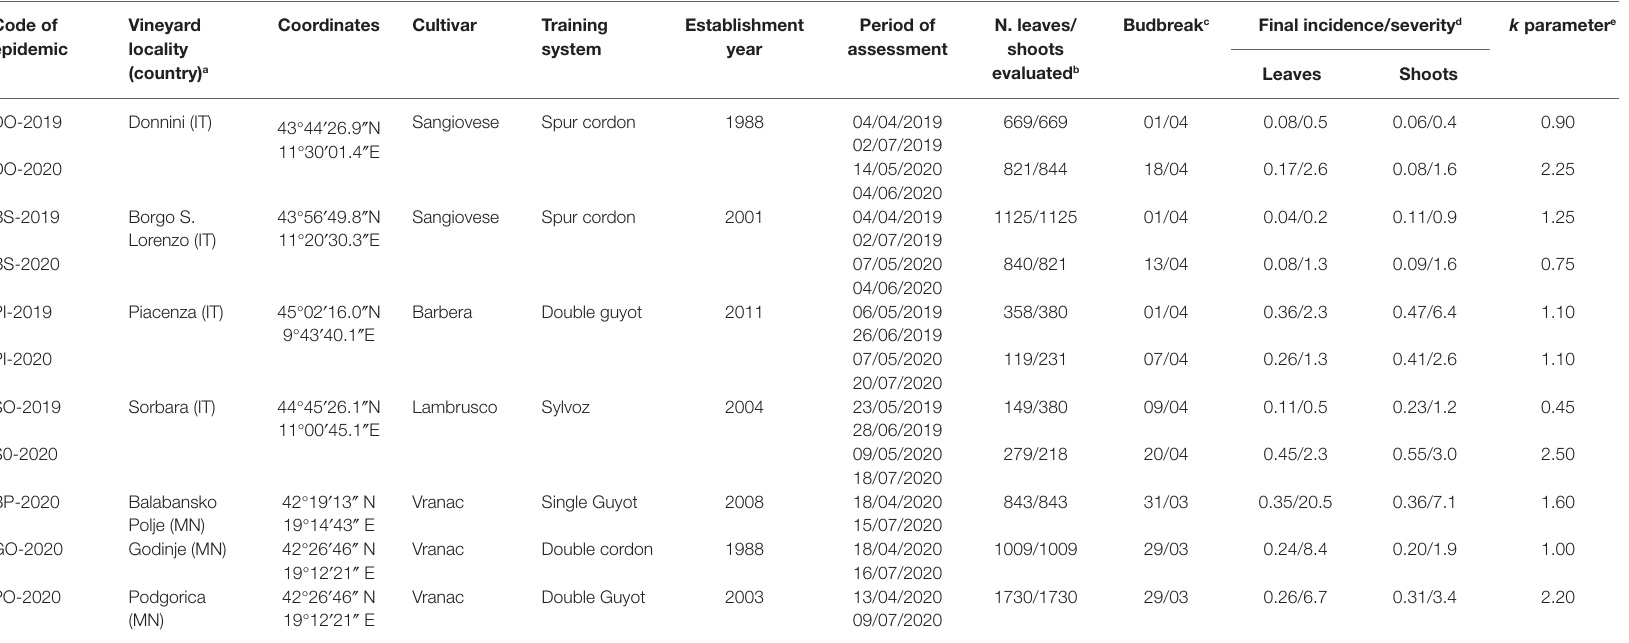
TABLE 2 | Summary of the characteristics of the vineyards used to validate the Diaporthe ampelina model. Code of